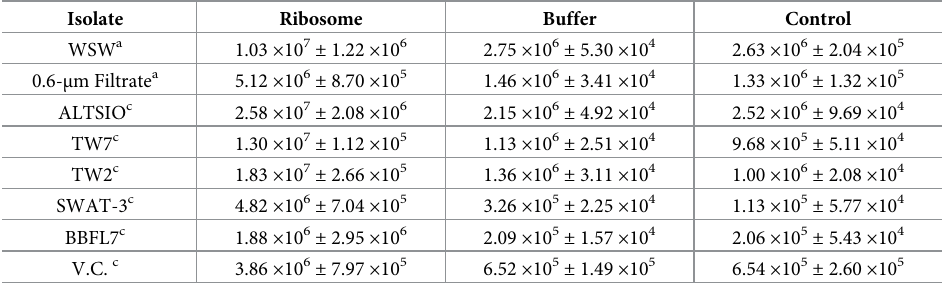
Table 1. Marine bacterial growth response to 18 hr incubation with ribosome